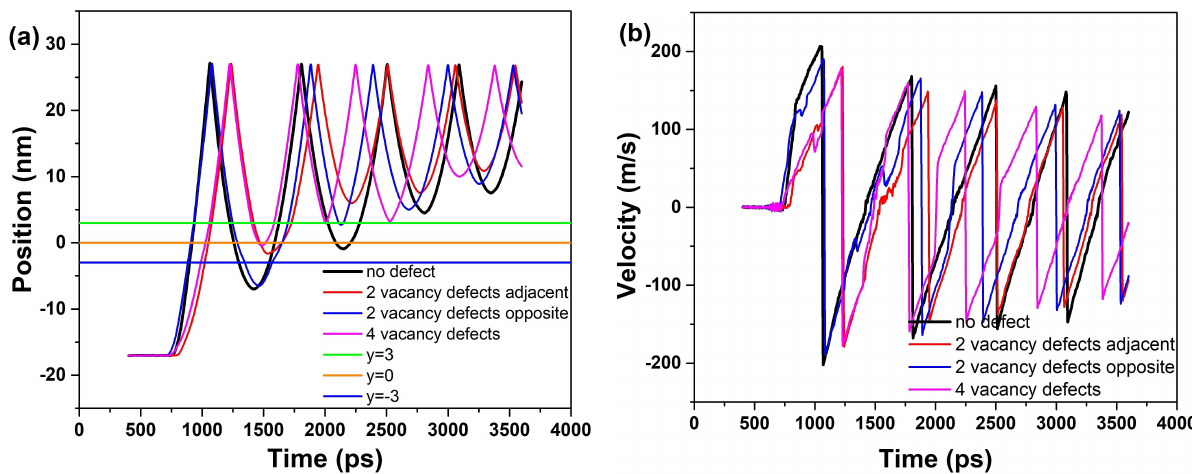
Figure 5: Variation of the movement behaviors with time for the system containing no defect, 2 vacancy defects adjacent, 2 vacancy defects opposite,4 vacancy defects in the inner nanotube: (a) The position with time. (b) The velocity with